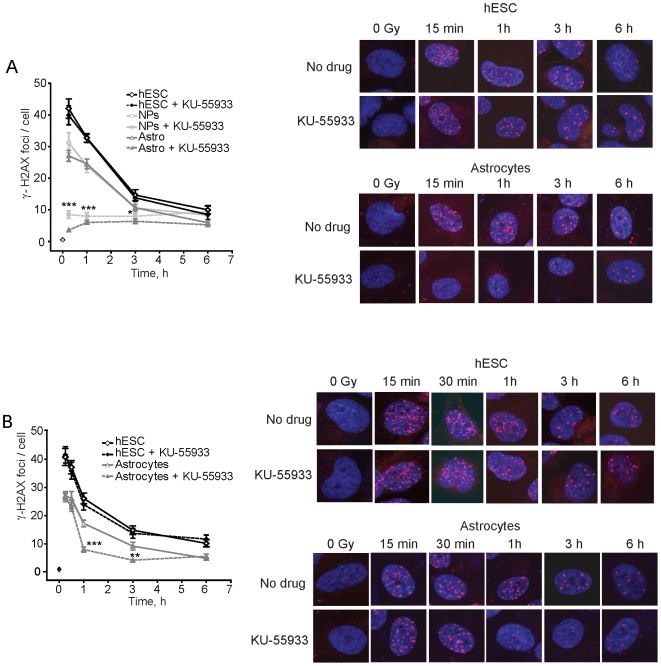
ATM kinase is important for γ-H2AX foci resolution in astrocytes but not in hESCs.Graphical depiction (left panel) and images (right panel) of γ-H2AX foci in hESCs, NPs, and astrocytes exposed to 10 µM KU-55933 A. 1 h prior to or B. 15 min after radiation with 2 Gy. There was <1 focus on average in the untreated hESC, NP and astrocyte populations (shown as symbols at time 0). Asterisks indicate statistical significance between the data sets generated with NPs and astrocytes, respectively, with KU-55933 present or not at the same time point. Data points, foci per nucleus; Error bars, SEM for data sets n = 50.